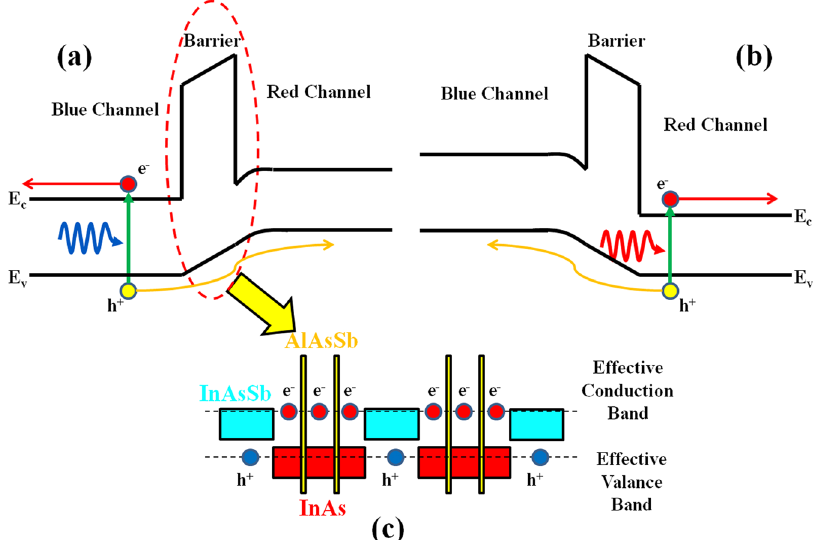
Figure 1. The schematic diagram and working principle of the bias-selectable nBn dual-band LWIR/VLWIR photodetector under ( a ) positive, and ( b ) negative applied bias voltage. The barrier blocks the transport of majority electrons, while, only, allowing the transport of minority holes and photo-generated carriers. ( c ) The band alignment and the creation of an effective bandgap in saw-tooth InAs/AlAs 1 − x Sb x /InAs/AlAs 1 − x Sb x /InAs/ InAs 1 − x Sb x superlattice of the barrier. Colored rectangles represent the forbidden band gap of the materials. The atomic engineering capabilities of T2SLs enable near–perfect valence band alignment of all three